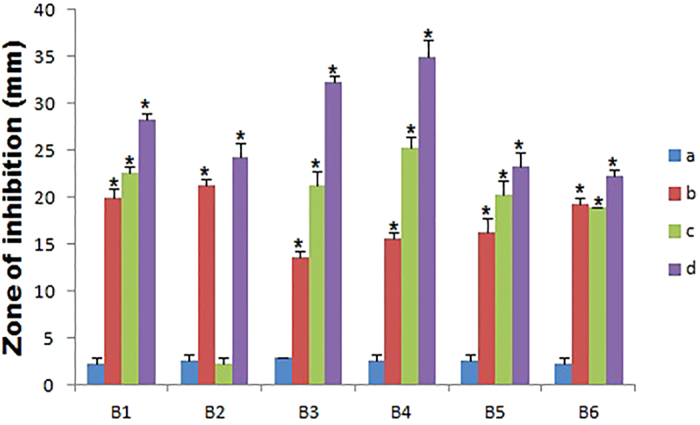
The Column chart showing the ZOI measurement of SNPs, topical antibiotic and combinations against E. coli.B1: Cefazolin; B2: Mupirocin; B3: Gentamycin; B4: Neomycin; B5: Tetracycline; B6: Vancomycin. a: Control; b: SNP; c: Topical antibiotic; d: SNP + Topical antibiotic. Values are expressed as means (n = 3), and error bars represent standard deviations. Asterisks (*) indicate a statistical significant difference (P < 0.05) between the control and the treatments.